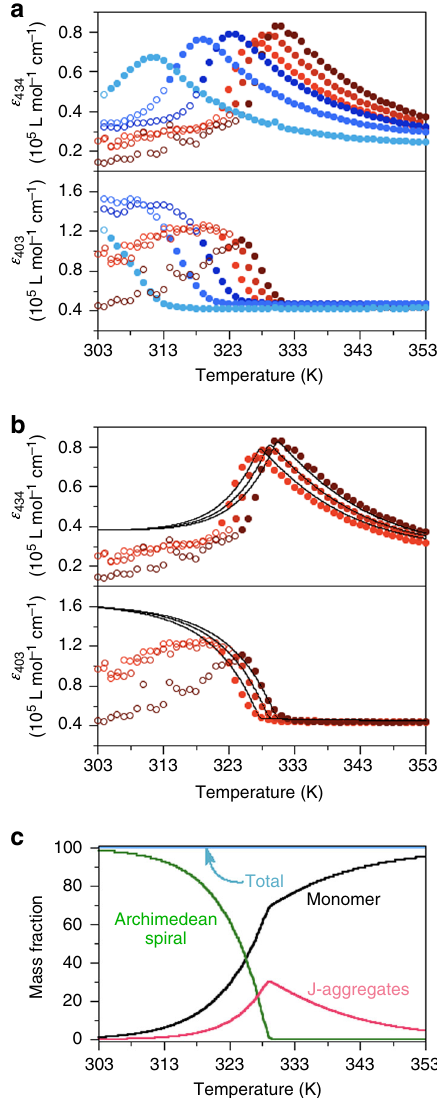
Fig. 4 Thermodynamic analysis. a Plots of molar absorption coef fi cients at 434 and 403 nm as a function of temperature: [ 6FF ] = 2.5, 5.0, 7.5, 10.0, 12.5, 15.0 μ M; − 0.5 K/min. It is noteworthy that the plots obtained at lower concentrations (bluish marks) and at higher concentrations (reddish marks) showed slightly different trends. b The two-pathway thermodynamic model was fi tted (solid lines) to the plots indicated by the reddish fi lled marks in a (i.e., the data points obtained at higher concentrations). c Calculated temperature-dependent speciation plot of a 12.5 μ M solution of 6FF . The speciation plot shows the distribution of monomers over the free monomeric, J-aggregated, and H-aggregated (Archimedean spiral) states (see also Supplementary Fig. 27). to the stronger enthalpic component for the formation of aggregates of 6FF , the entropic penalty for the formation of aggregates of 6FF is also considerably more negative than that for the aggregation of 6FH . This increased entropic penalty suggests that the side chains in the Archimedean spirals of 6FF are more organized and structured compared with those of 6FH . Pre- sumably, the poorer solubility of the fl uorinated side chains in aliphatic environments drives this stronger organization. Thus, by balancing the degree of fl uorination of the side chains, fi ne control of thermal properties of the supramolecular structures is attainable.